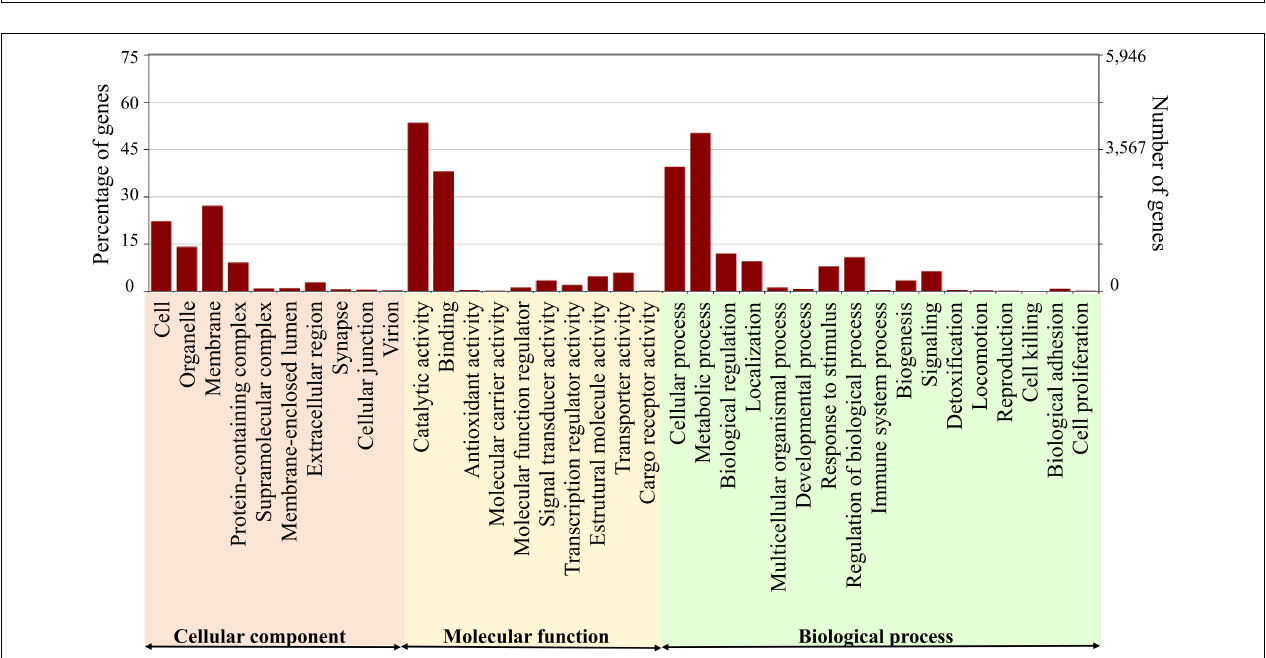
FIGURE 1 | Distribution of alignments and transcripts of de novo assembly of control larvae of Diatraea saccharalis parasitized and pseudoparasitized by Cotesia flavipes after search for similarity in NCBI databank; (A) Groups represented by de novo assembly; (B) Lepidoptera species obtained in the annotation of transcripts of D. saccharalis: Manduca sexta; Ostrinia furnacalis; Pectinophora gossypiella; Chilo suppressalis; Papilio polistes; Ophemerata brunata; Danaus plexippus; Papilio xuthus; Papilio machaon; Bombyx mori; Helicoverpa armigera; Amyelois transitella .